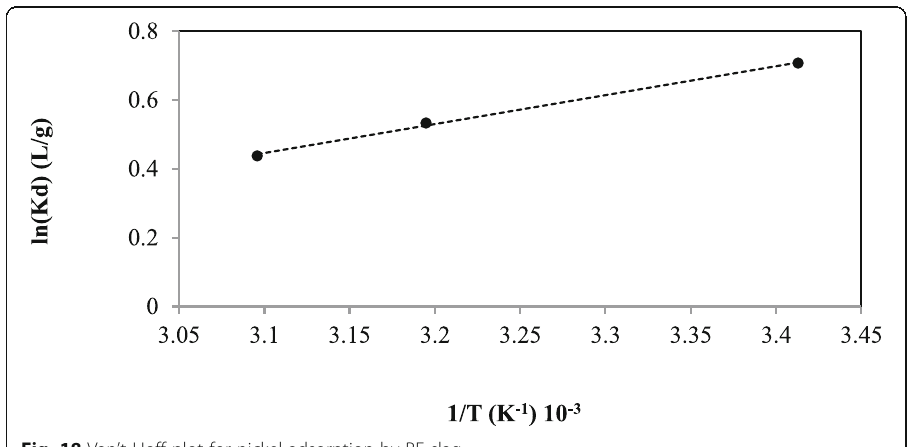
Fig. 18 Van ’ t Hoff plot for nickel adsorption by BF